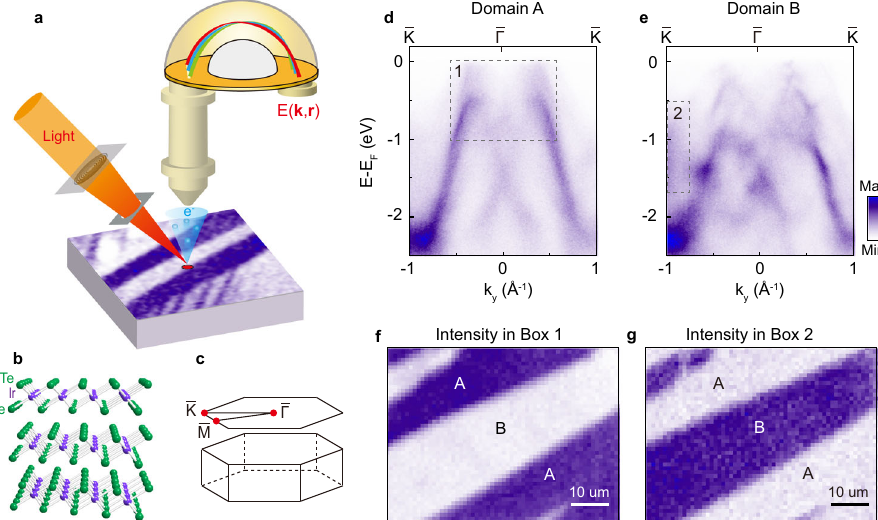
Fig. 1 Resolving the distinct electronic structures of separated domains in IrTe 2 by NanoARPES with energy-, momentum-, and space-resolved information. a A schematic drawing of NanoARPES and MicroARPES. The light beam is focused onto the sample by a Fresnel zone plate or a lens down to a few μ m or even 100 nm scale and generate the photoelectrons which is measured by the analyzer. b , c Crystal structure of IrTe 2 and the corresponding Brillouin zone above the stripe transition temperature. d , e Two characteristic dispersions observed in domains A and B (as labeled in panels f and g ) measured at photon energy of 100 eV with p -polarization and temperature of 80 K. f Spatially resolved intensity map integrated over box 1 of panel d . g Spatially resolved intensity map integrated over box 2 of panel e